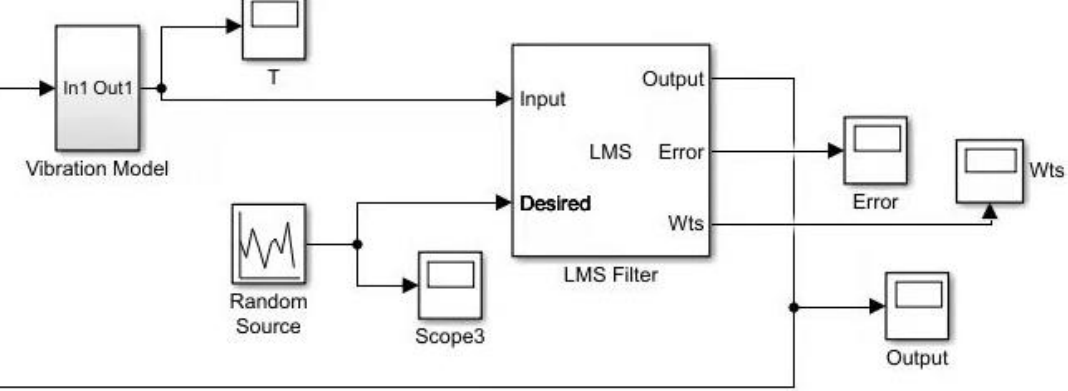
Figure 7. The dynamics Simulink model using LMS vibration control.